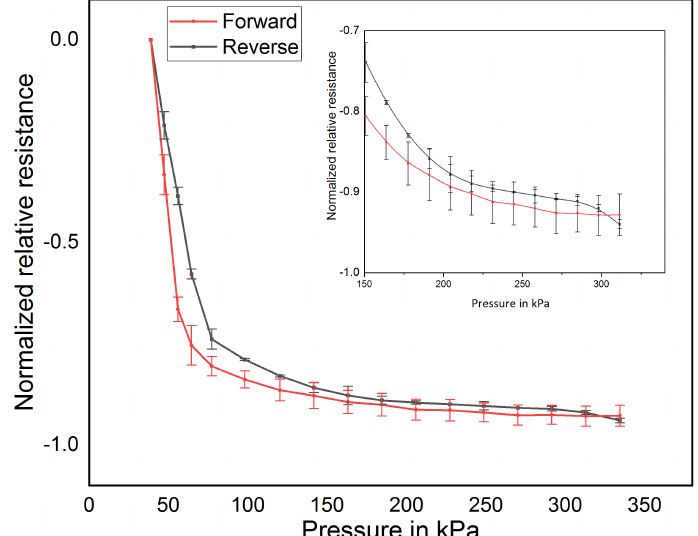
Figure 11. Electro-mechanical behavior of CNT/PDMS pressure sensors implemented in the